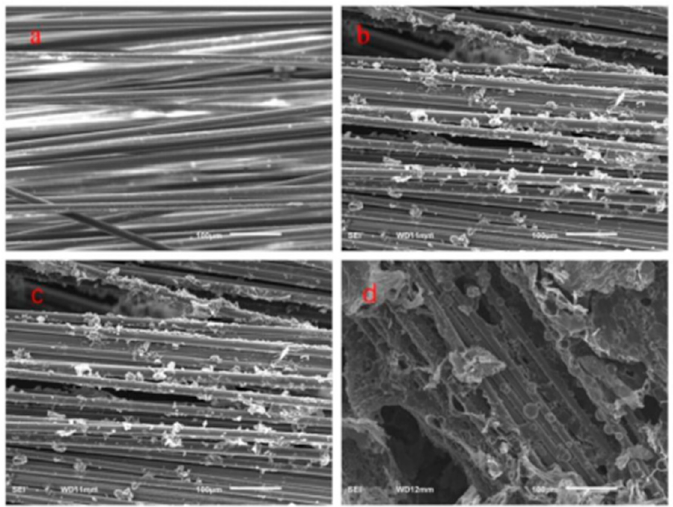
Figure 11. SEM images after cone calorimeter testing of ( a ) CGF/PP ( b ) CGF/PP/20IFR/HPP ( c ) CGF/PP/25IFR/HPP ( d ) CGF/PP/30IFR/HPP.